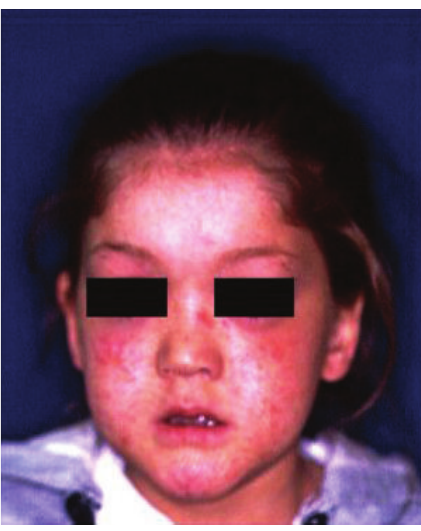
Figure 1: Telangiectatic appearance of the face of patient.